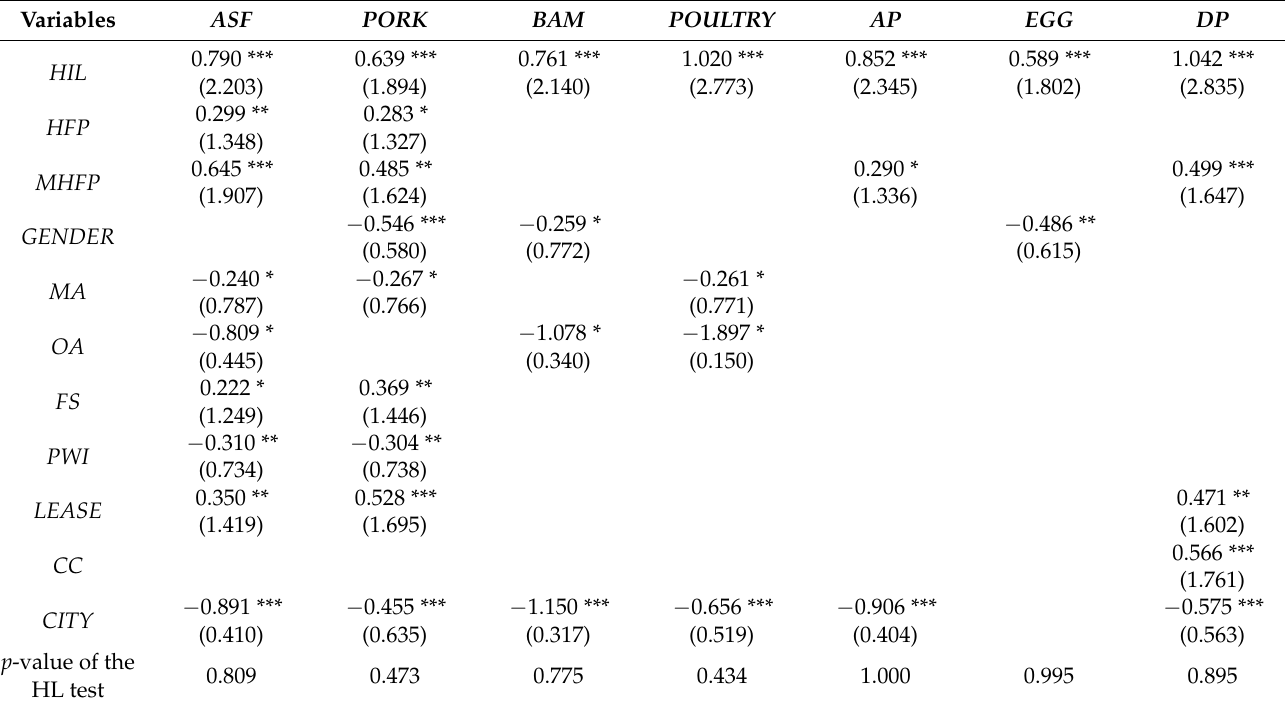
Table 4. Binary logistic regression results and probability ratio results of